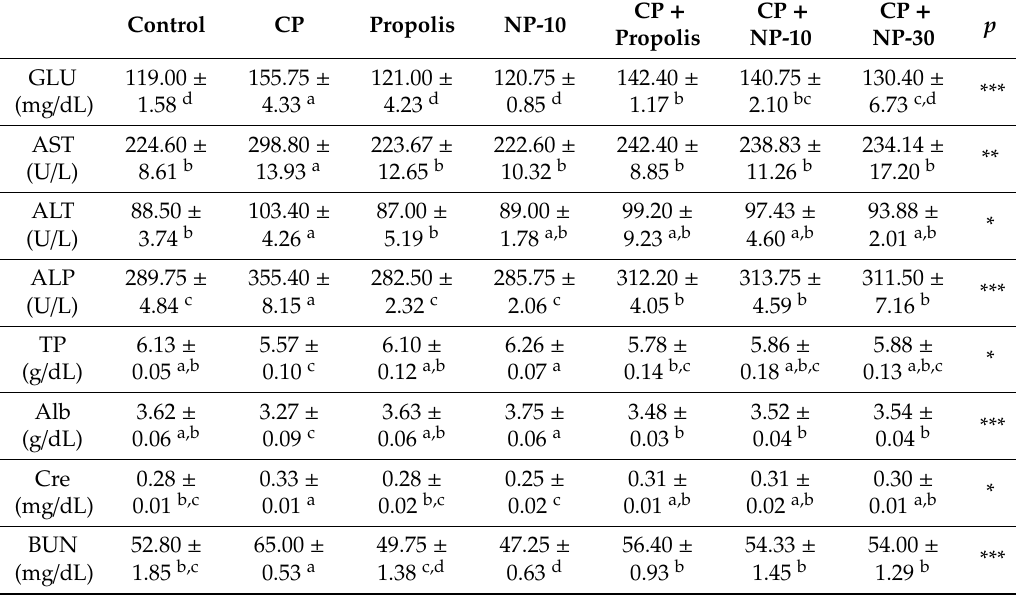
Table 2. E ff ects of propolis and nano-propolis on biochemical parameters of experimental groups (Mean ±